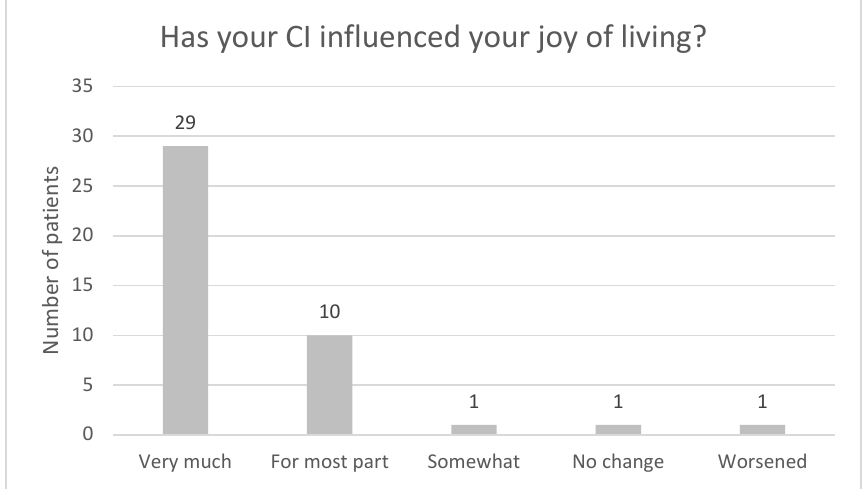
Figure 5. To what extent was your CI worth the effort?